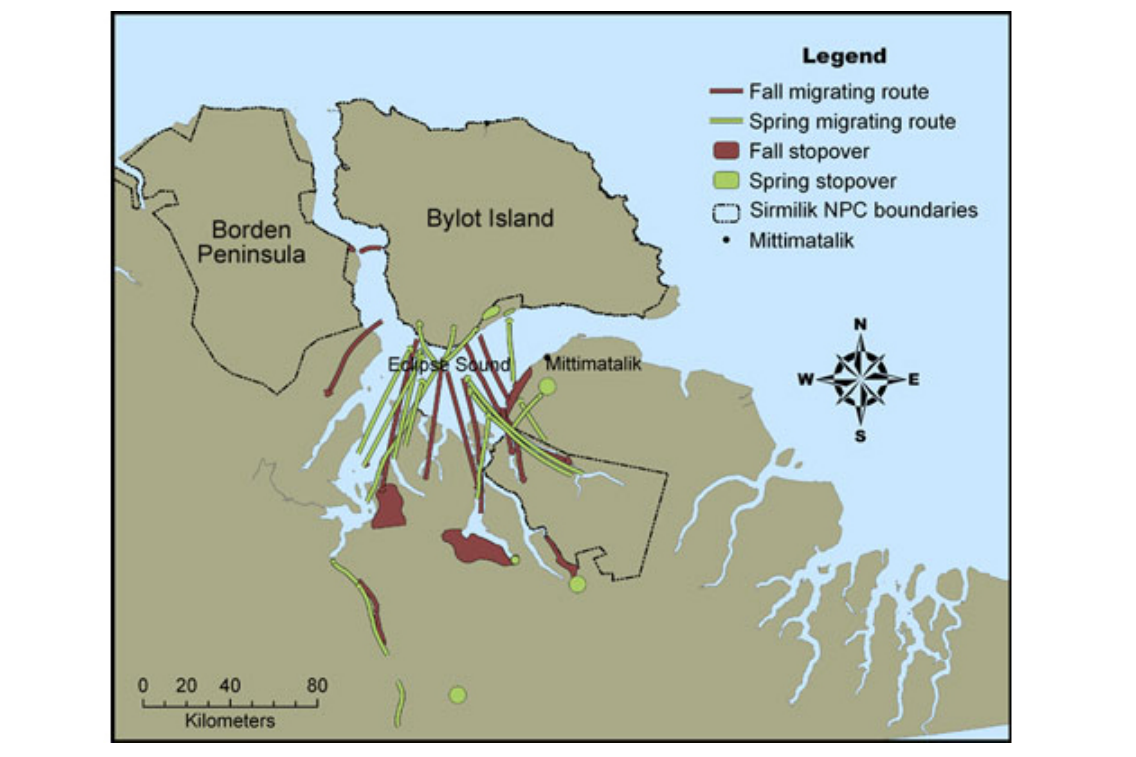
Fig. 6 . Fall and spring migration routes and feeding stopover sites of greater snow geese ( Chen caerulescens atlantica ), as reported by the local experts from Mittimatalik, Nunavut, Canada, interviewed in this